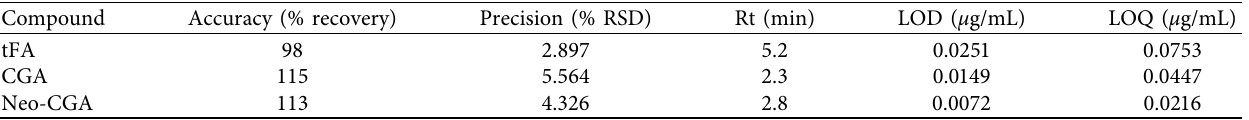
Table 5: Validation parameters HPLC-DAD, analytical characteristics, and method validation data for HPLC using a Cortex 2.7 μ m, 4.6 × 150 mm column.